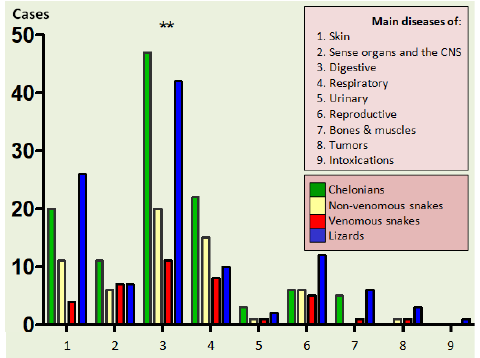
Figure 1. Comparing the incidence of digestive diseases and other diseases within the reptile category as diagnosed in this study (where: ** means p < 0.01).